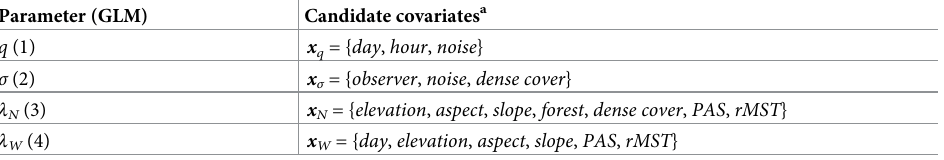
Data exploration (S1 File) suggested covariates likely to influence the observation process (Table 4), and these candidate covariates of q and σ were evaluated jointly in a preliminary Table 4. Candidate covariates for each generalized linear model (GLM) of key parameters in the white pine- Clark’s nutcracker analysis (Fig 2): q = per-minute probability of non-detection, σ = scale parameter of the half- normal distribution, λ N = expected abundance of nutcrackers, and λ W = expected value of a time-varying white- bark seed proxy (Table 3). Parameter (GLM) Candidate covariates a q (1) x q = { day , hour , noise } σ (2) x σ = { observer , noise , dense cover } λ N (3) x N = { elevation , aspect , slope , forest , dense cover , PAS , rMST } λ W (4) x W = { day , elevation , aspect , slope , PAS , rMST } a Fixed and/or random effects of year were also considered; see Eqs (3) and